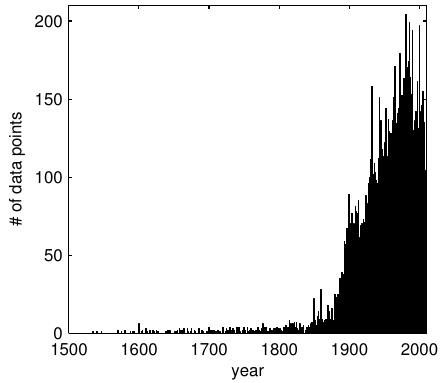
Fig. 3. Number of glacier length records per region (grey) and the total area covered by glaciers in this region, as given by the RGI (Arendt et al., 2012) (black). The regions correspond to Fig 2. Can Arct gives the glacier-covered area in the Canadian Arctic (regions 3 and 4 in the RGI), which is not represented in the glacier length data set.